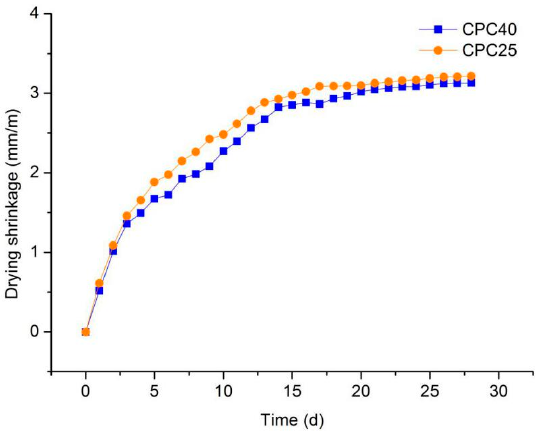
Figure 12. Drying shrinkage of series III mixtures.